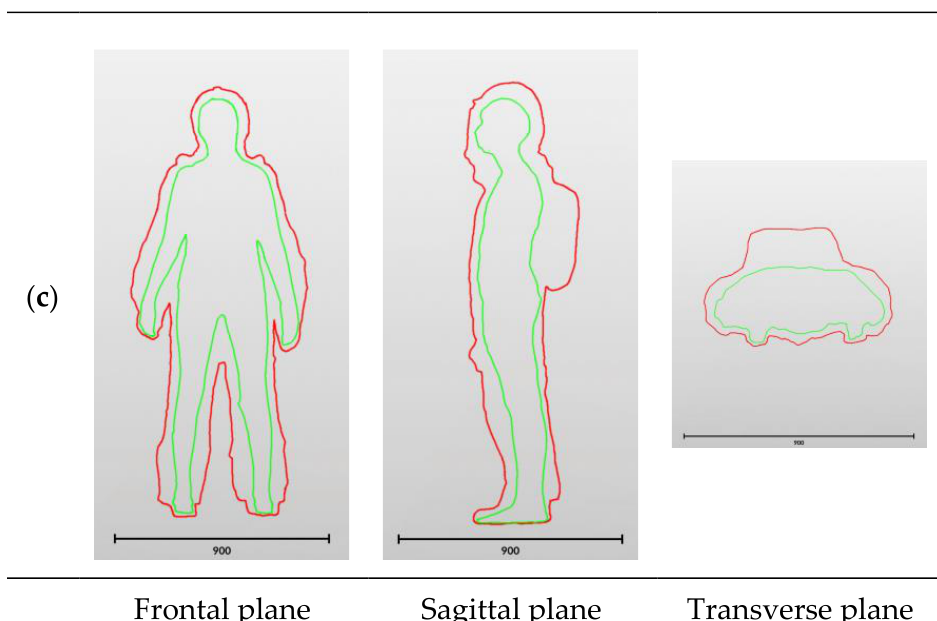
Sagittal plane Transverse plane Figure 3. View of dimensional allowances arising from the use of full welding ( a ), firefighting ( b ), and mine rescue ( c ) PPE kits in the frontal plane (height and width DAs),the sagittal plane, and the transverse plane (circumference DAs at shoulder level).